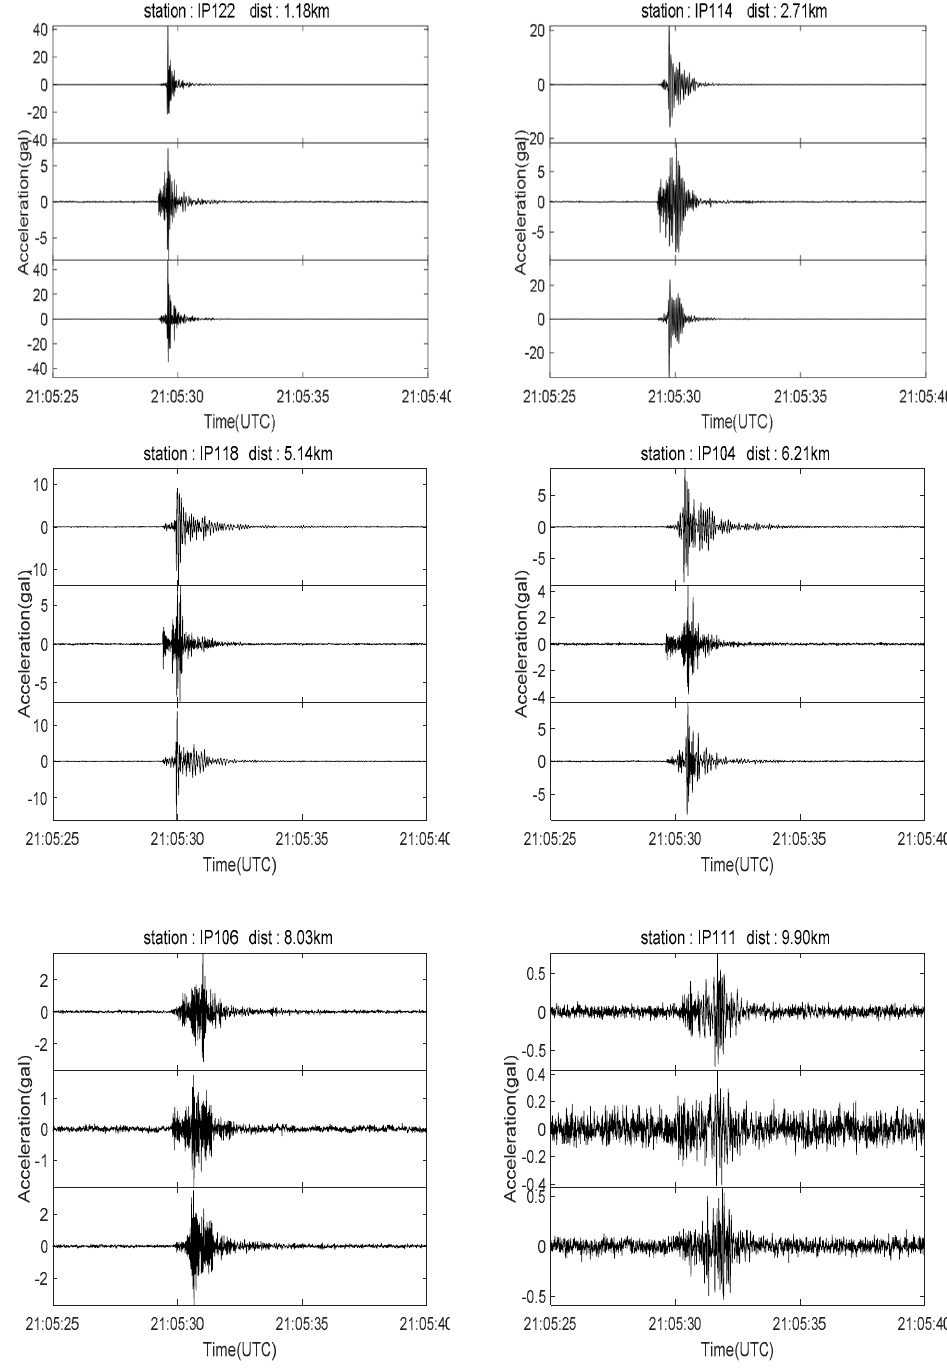
Figure 14. Seismogram from a close range M2.2 earthquake that occurred at 21:05:27 (UTC time), 23 July 2020, with a hypocentral depth of 3 km, a sampling rate of 200 Hz, and a bandpass filter of 0.1–20 Hz.